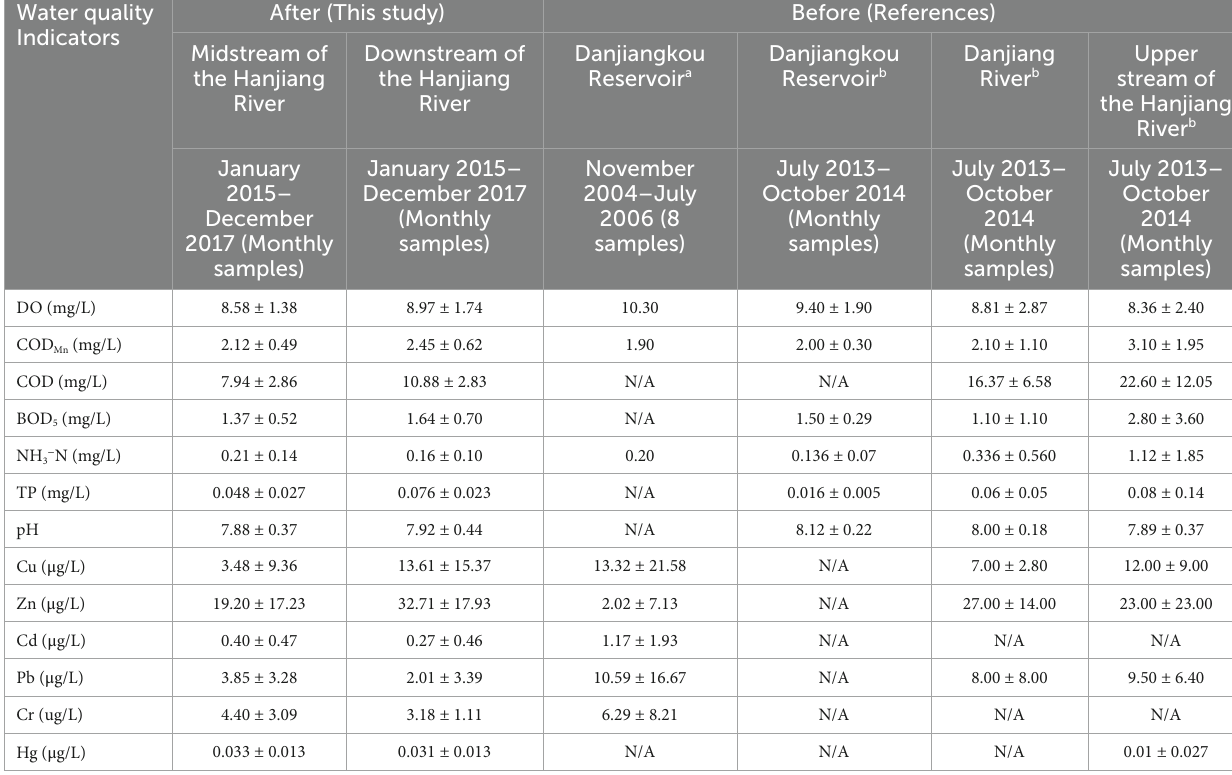
TABLE 5 Comparison of water quality regimes before and after the operation of the MRSNWDPC. Water quality